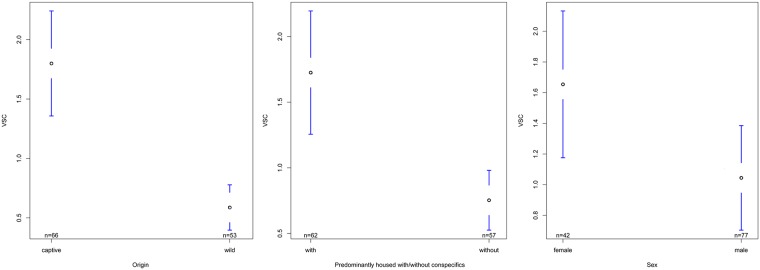
Confidence Interval plots of VSC and all significant fixed factors (Origin, PHCinfant, Sex).Mean vertex strength centrality (±95% CI).